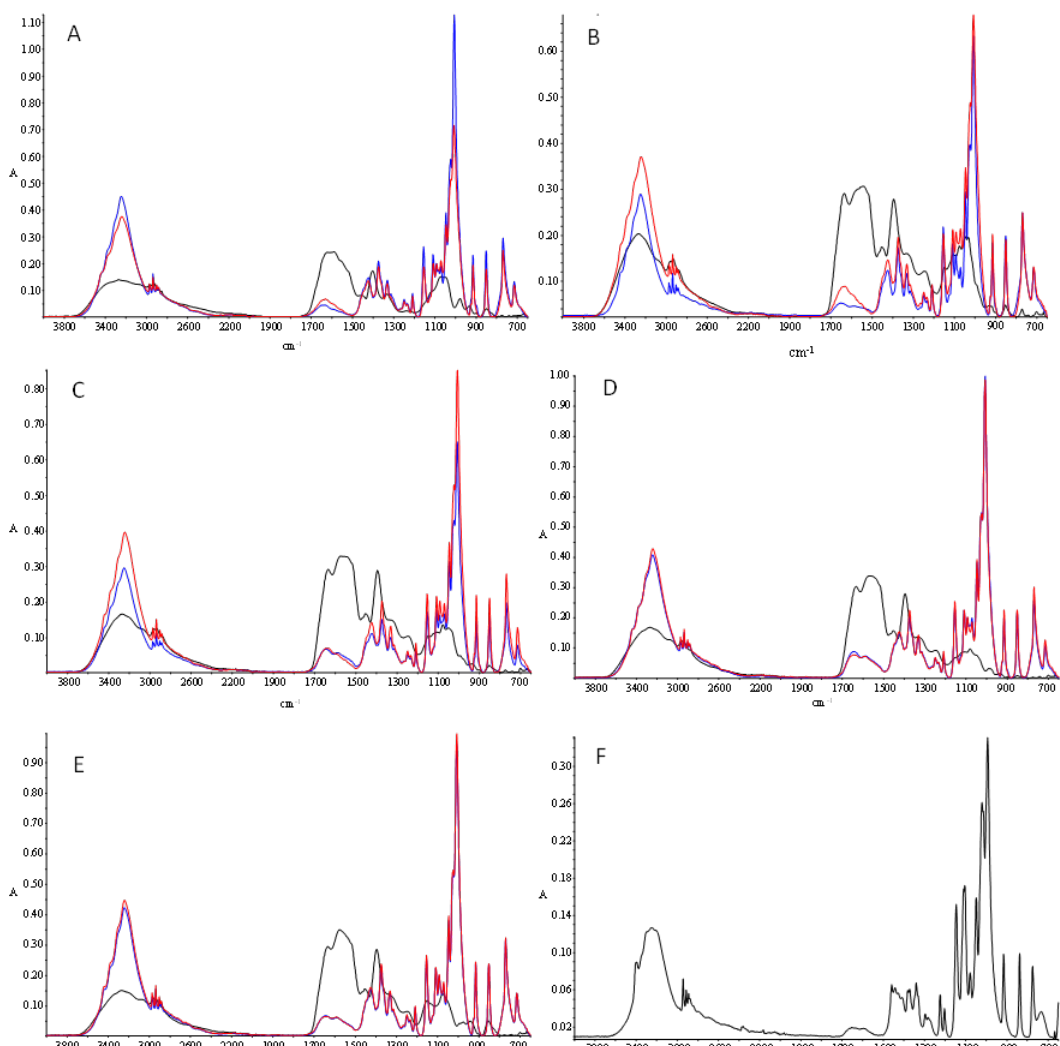
Figure 3. FTIR spectra of control ( A ), H10 ( B ), H30 ( C ), H60 ( D ), and H120 ( E ) samples. Black, blue, and red lines represent the non-glycated samples and the samples subjected to reaction with glucose for 40 min or 180 min, respectively. Figure ( F ) represents the spectrum of glucose.